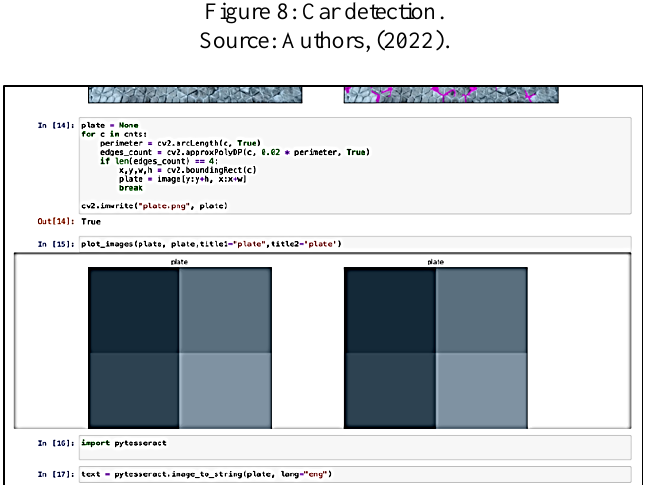
Figure 8: Car detection.